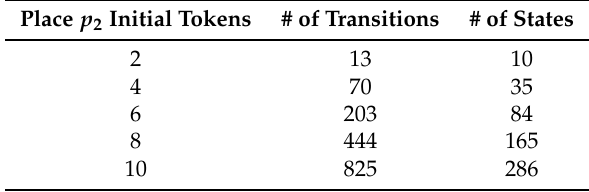
Table 1. Number of fired transitions and global states in the state-space as a function of the initial marking at p 2